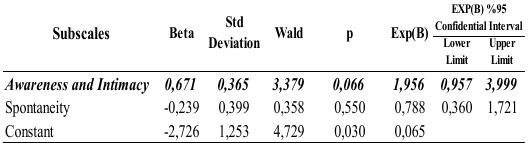
Table 4: Results of Binary Logistic Regression